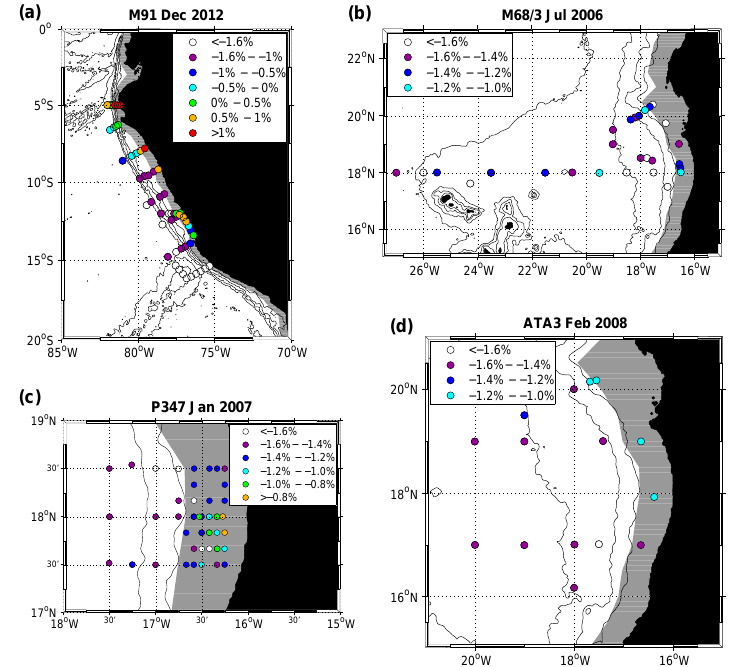
Figure 1. δ 3 He [%] in the mixed layer for cruise M91 off Peru (a) and for cruises M68/3, P347 and ATA3 off Mauritania (b–d) . Isobaths are drawn every 1000m, and the area of the “coastal region” is shaded grey (for details, see text). Note the different colour scale for the cruises from the Peruvian (a) and Mauritanian (b–d) region. The error of the δ 3 He values in the mixed layer is